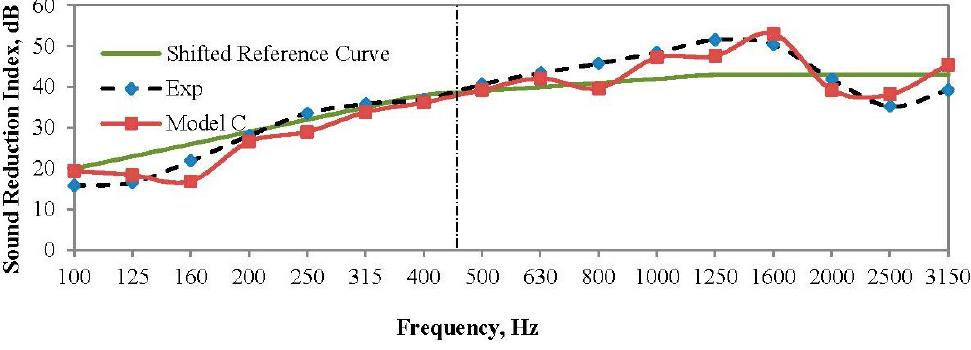
Figure 10. Shifted reference curve with respect to measured R